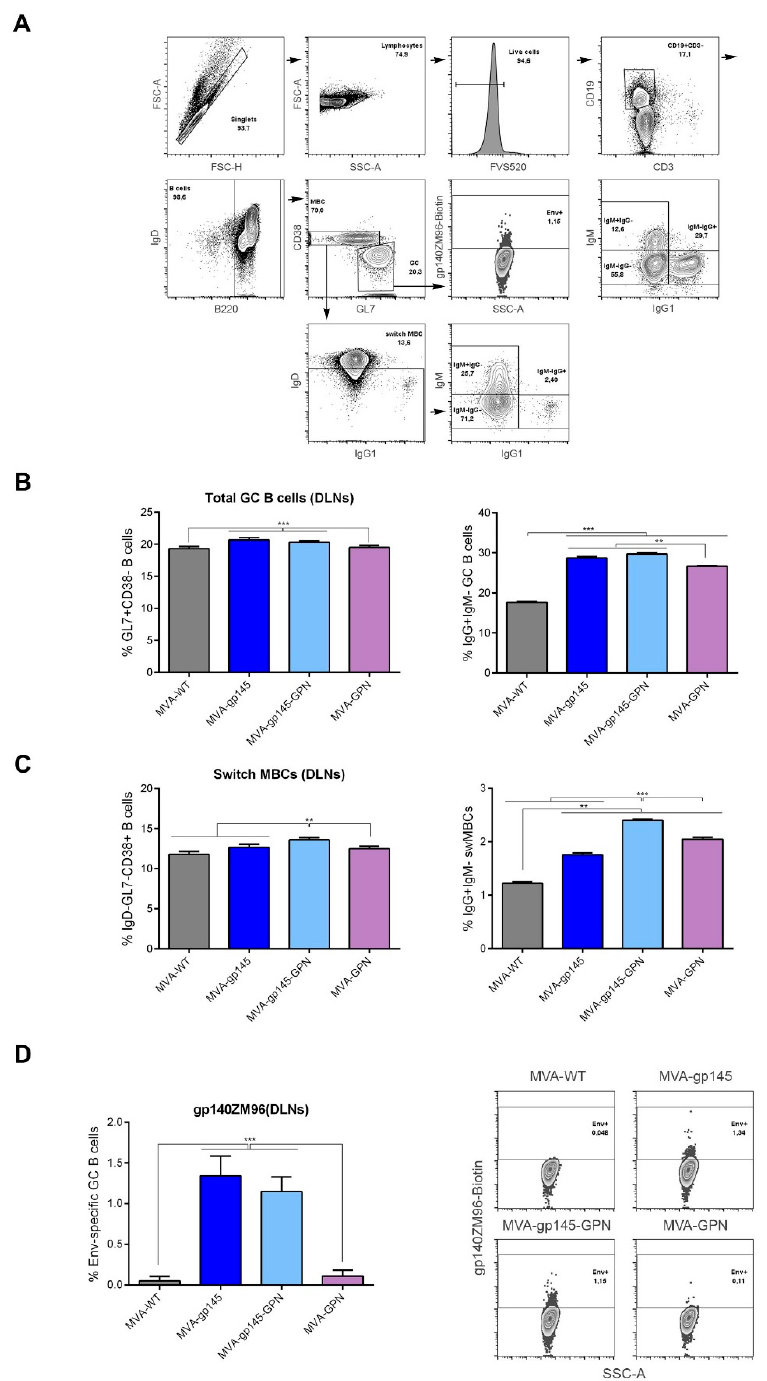
Figure 5. Env-specific B cell immune response elicited in DLNs after prime/boost homologous immunization of mice with different MVA-based recombinant viruses expressing gp145 and/or GPN antigens. ( A ) Flow cytometry strategy for the identification of total B cells ( B ), memory B cells (MBCs) ( C ) and Env-specific B cells ( D ) in lymphocytes from DLNs of immunized mice. B cells lymphocytes were identified as B220 + cells gated on singlets/live/CD3 - CD19 + population. On B cells, we defined GC B cells (GL7 + CD38 - ), memory B cells (MBCs) (GL7 - CD38 + ) and class-switched MBCs (IgD - and IgG1 + IgM - ) populations. Biotinylated gp140 protein was used to identify the frequency of Env-specific